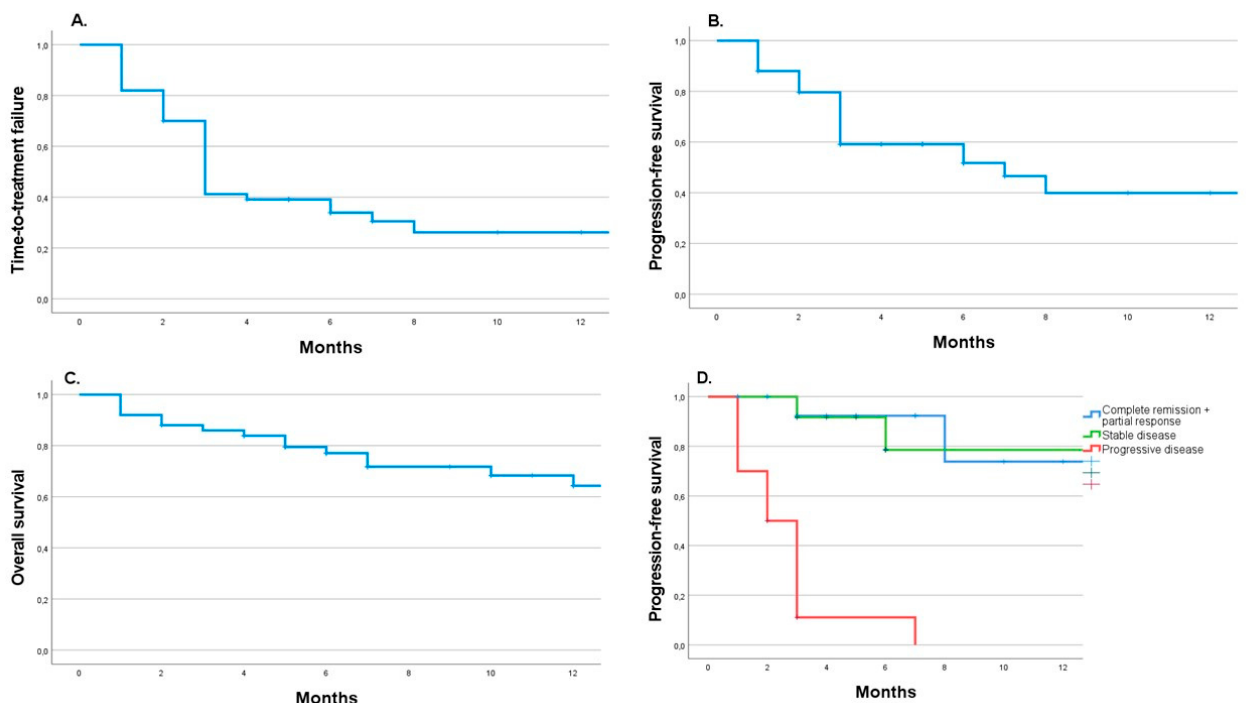
Figure 2. Kaplan-Meyer curves for time-to-treatment-failure ( A ), progression-free survival ( B ), and overall survival ( C ) in the whole group of patients and progression-free survival depending on the results of first imaging ( D ).